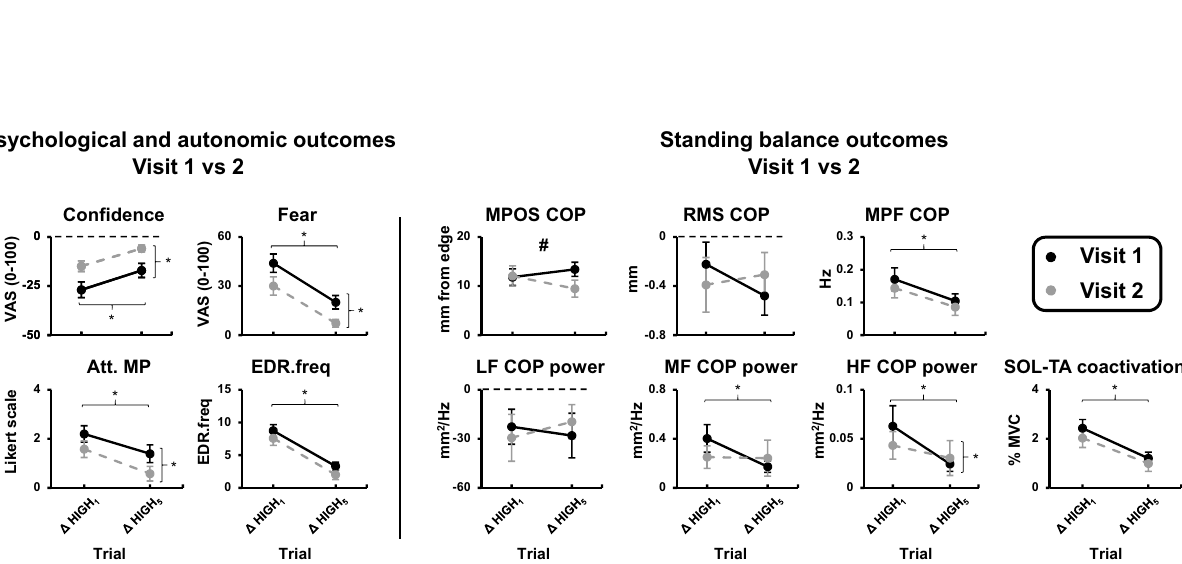
Figure 6. Effect of visit and trial on psychological, autonomic, and standing balance outcomes. Data presented reflect group means and standard errors of change scores (Δ HIGH 1 = HIGH 1 – LOW pre ; Δ HIGH 5 = HIGH 5 – LOW pre ). Change scores for visit 1 and 2 are presented as filled black and grey circles, respectively. Att. MP = attention toward movement processes; COP = centre of pressure; EDR.freq = non-specific electrodermal response frequency; HF = high frequency; LF = low frequency; MF = medium frequency; MPF = mean power frequency; MPOS = mean position; RMS = root mean square; SOL = soleus; TA = tibialis anterior; VAS = visual analog scale. Vertical and horizontal brackets with asterisks indicate significant main effect of visit and trial, respectively ( p < 0.05). Hashtags represent significant visit × trial interaction ( p <